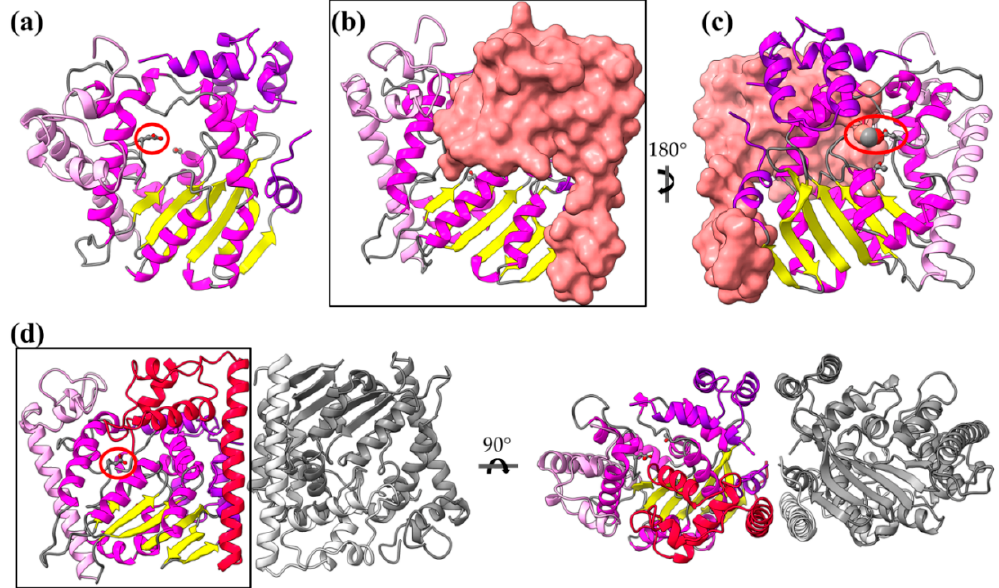
Figure 11. The structure of AvrRxo1-ORF1 and its complex with the AvrRxo1-ORF2 chaperone (PDB id 4Z8V). ( a ) The AvrRxo1-ORF1 monomer consists of a major, middle α / β domain (helices are colored in magenta) and two flanking domains, whose helices are colored pink and violet, respectively. ( b , c ) The 1:1 complex of AvrRxo1-ORF1/AvrRxo1-ORF2 in two views, 180 degrees apart. AvrRxo1-ORF2 is shown in surface representation. ( d ) The 2:2 complex of AvrRxo1- ORF1/AvrRxo1-ORF2 in two views, 90 degrees apart. One dimer is gray and the other is colorful, consistent with colors in ( a ). AvrRxo1-ORF2 is shown in red cartoon.